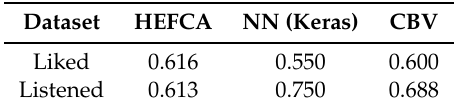
Table 7. Accuracies of HEFCA, neural network and CBV on real-world problems.